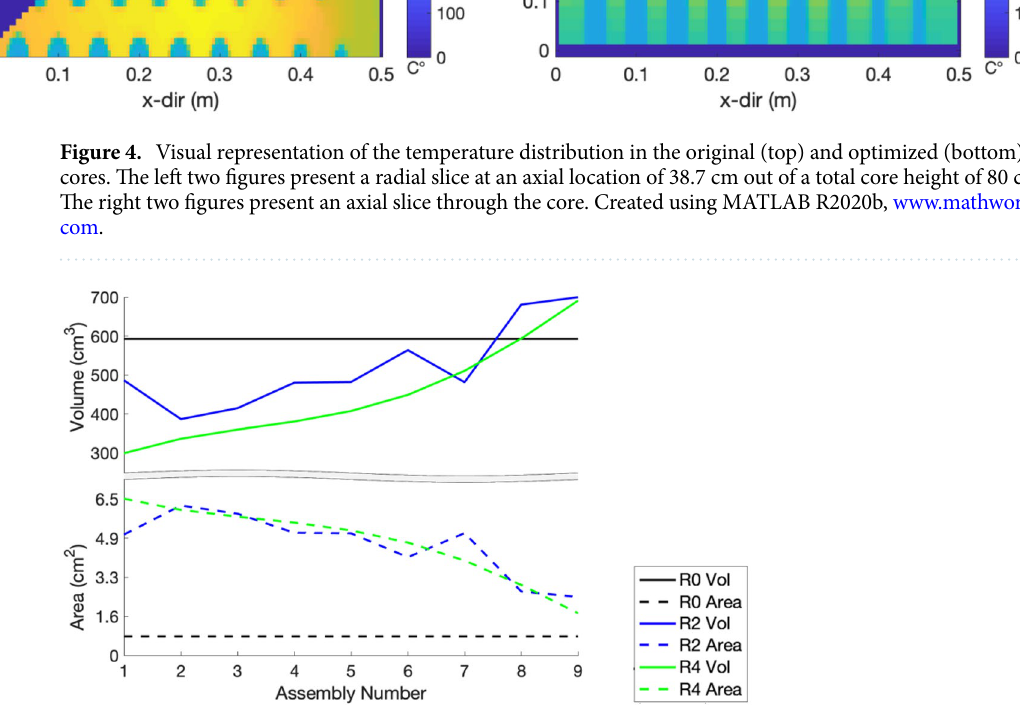
Figure 5. Plot of the fuel volume per assembly (top) and the heat-exchange area for the cooling channel in each assembly (bottom). The three different colors represent different iterations of the optimization algorithm: initial (R0) and two later iterations (R2 and R4). Here, R0, R2, and R4 are shorthand for iteration round zero, two, and four, respectively. Created using MATLAB R2020b, www. mathw orks.